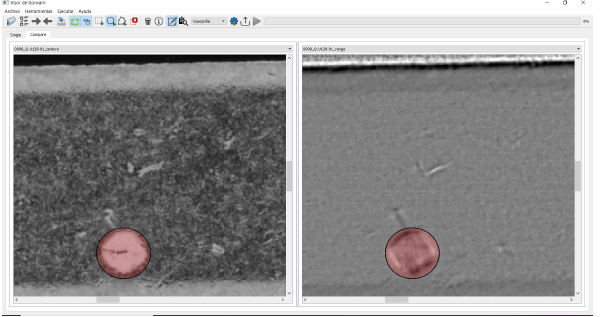
Figure 7. Customized annotation tool showing a side by side view of texture channel ( left ) and range channel ( right ) of an interest region of the component.